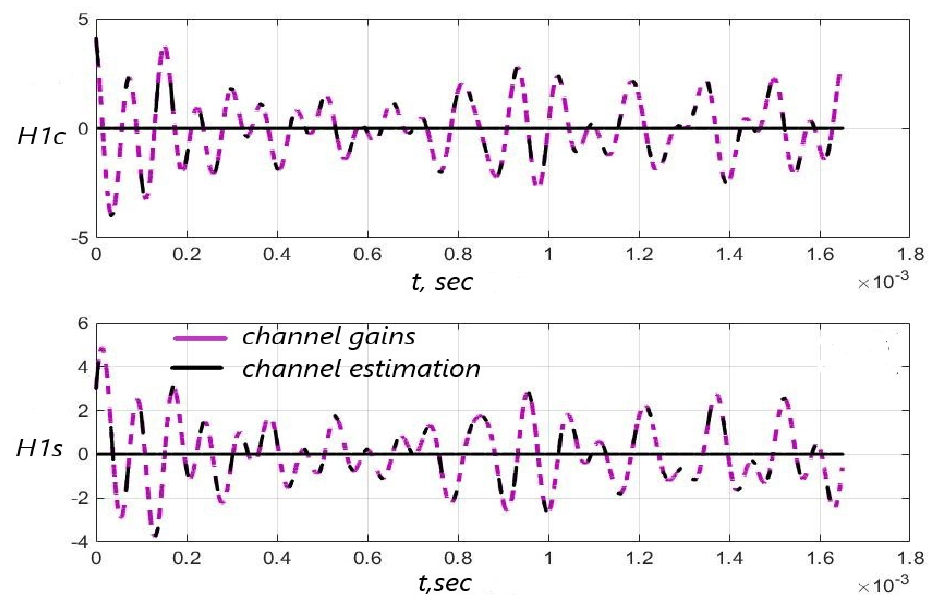
Figure 15. Channel gains H 1 c ( i ) , H 1 s ( i ) and their estimation based on the test signal versus time: ( F + ∆ f ) T = 3.5 × 10 − 3 , p = 1, SNR = 26 dB. D